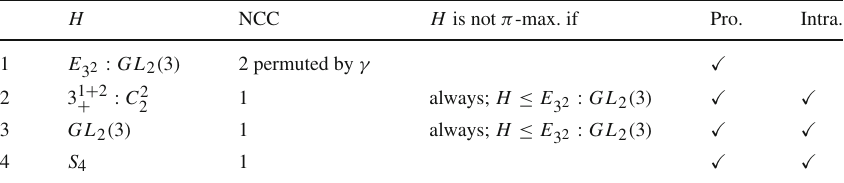
Table 11 The π -submaximal subgroups of S = L 3 ( 3 ) . Case: π ∩ π( S ) = { 2 , 3 } γ ∈ Aut ( S ) \ Inn ( S ) , | γ | = 2, Aut ( S ) = (cid:11) Inn ( S ),γ